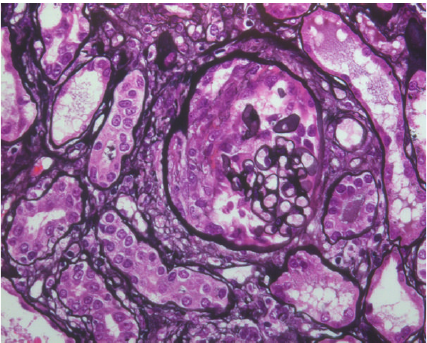
Figure 2: The methenamine silver stain shows fibrinoid necrosis with early crescent formation in the urinary space (Jones methen- amine silver, ×